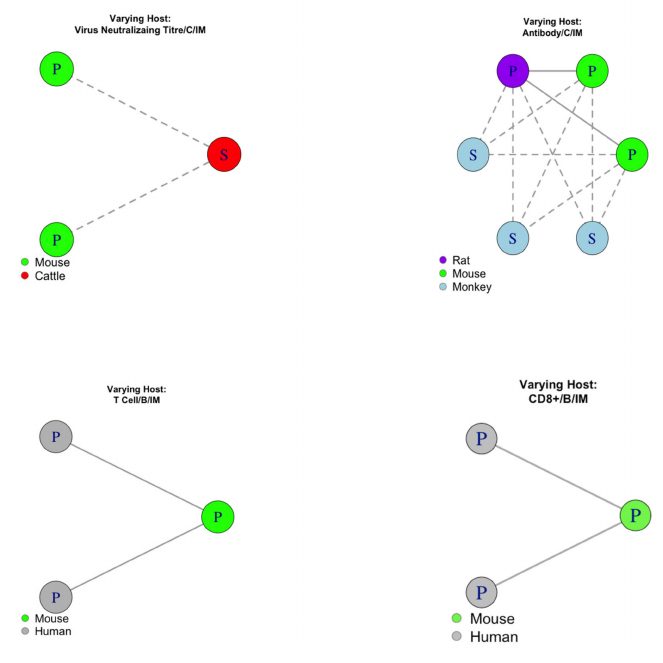
Figure 4. Pairings that di ff ered in host species, examined for analysis of consistency between groups. Each point represents a dataset that provided evidence, where P / S denotes the dataset had evidence towards a peaking / saturating shape, respectively. Datasets were colour coded according to their host. A solid line shows consistent pairings and a dashed line shows inconsistent pairings. B = species B adenoviral vector. C = species C adenoviral vector. IM = Intramuscular route of